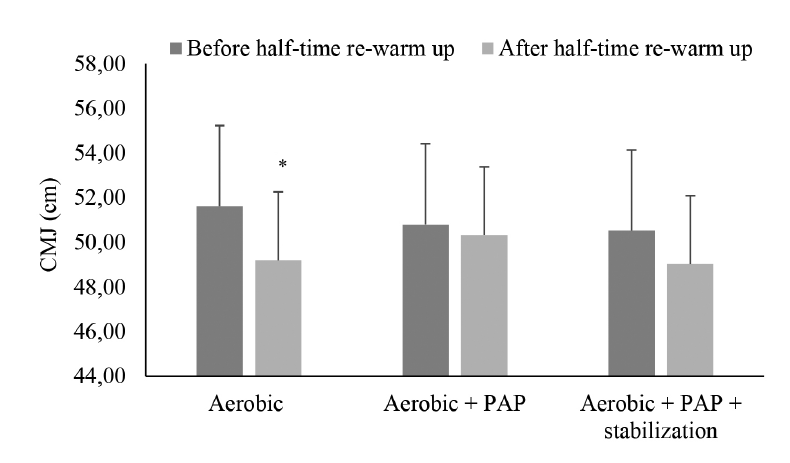
Note . * – significantly different between results before and after re-warp